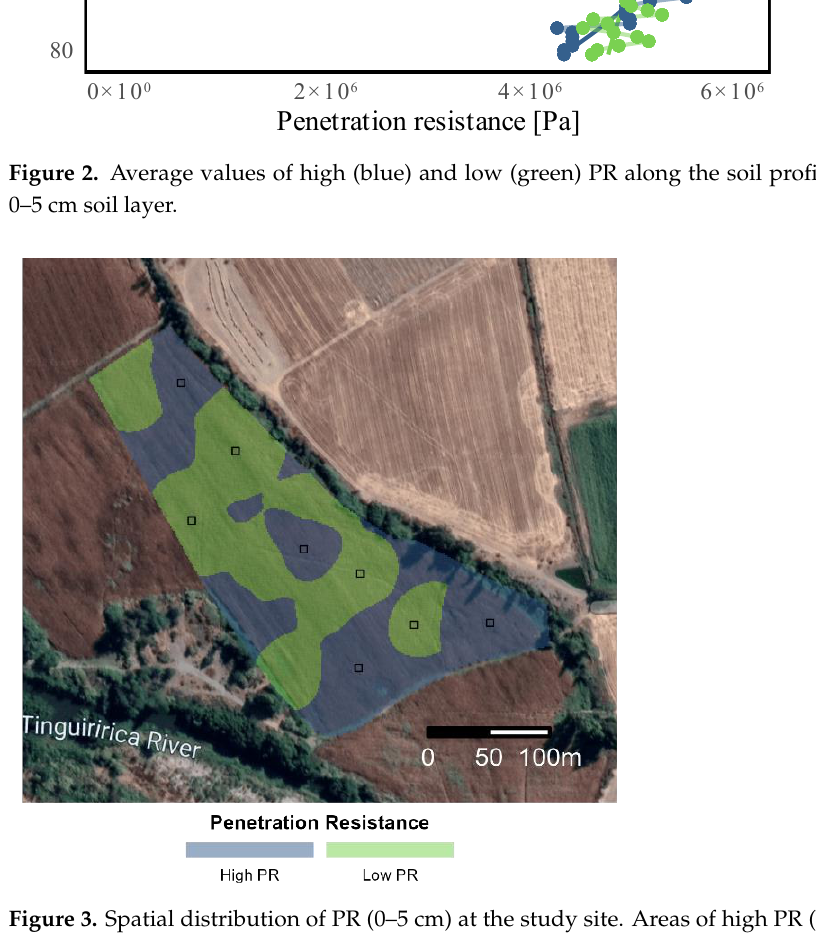
Figure 2. Average values of high (blue) and low (green) PR along the soil profile, defined in the 0 – 5 cm soil layer.